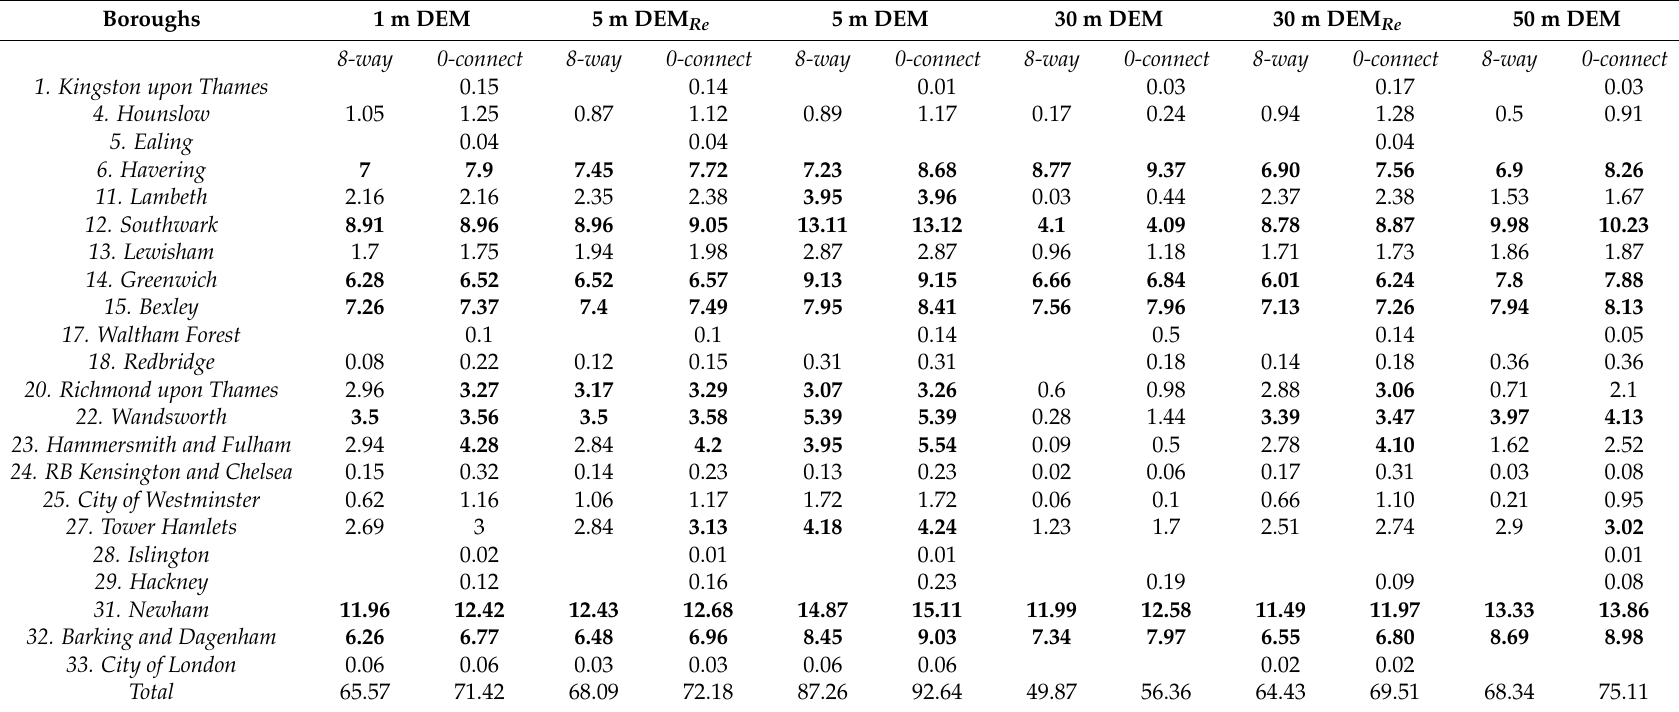
Table A2. Potential inundation areas for Greater London boroughs obtained from the 0.82 m RCP8.5 global sea-level rise scenario as estimated from six different elevation datasets (Section 2.1) and two different connectivity (eight-way hydrological and zero) approaches (Section 2.2). Only the boroughs that will be impacted are included (compare with Figure 1). Bold values indicate boroughs having ě 3 km 2 inundation